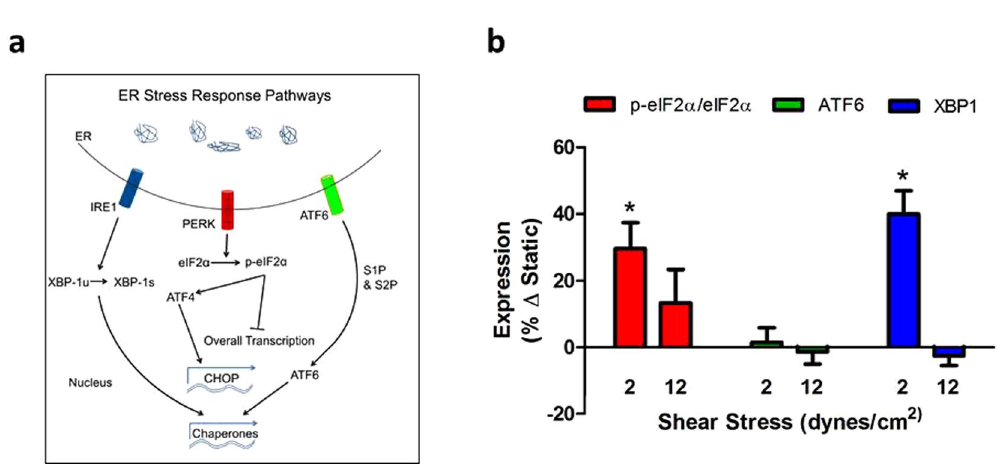
Figure 5. SS differentially modulates activation of ER stress response pathways. ( a ) ER stress is characterized by overload of protein processing and is reflected by changes in morphology, specifically an increase in ER- membrane expansion to accommodate the unfolded protein response (UPR) 12, 13 . Activation of the UPR is initiated by dissociation of binding immunoglobulin protein (BiP) from three proximal signaling proteins: activating transcription factor 6 (ATF6), inositol-requiring enzyme 1 α (IRE1 α ), and protein kinase-like extracellular signal-regulated kinase (PERK), which in turn activate distinct downstream effectors in order to maintain homeostasis. ATF6 is further processed and activated by the Golgi and IRE1 α is autophosphorylated leading to upregulation of the transcription factor x-box binding protein 1 (XBP1). PERK phosphorylation leads to activation of eukaryotic initiation factor-2 α (eIF2 α ). ( b ) HAEC were treated with TNF α and SS for 4 hrs and immunolabeled for the ER stress pathways proteins eIF2 α , p-eIF2 α , ATF6, XBP1. Values are mean ± SE, n = 3–4, * P < 0.05 comparing low to high SS within